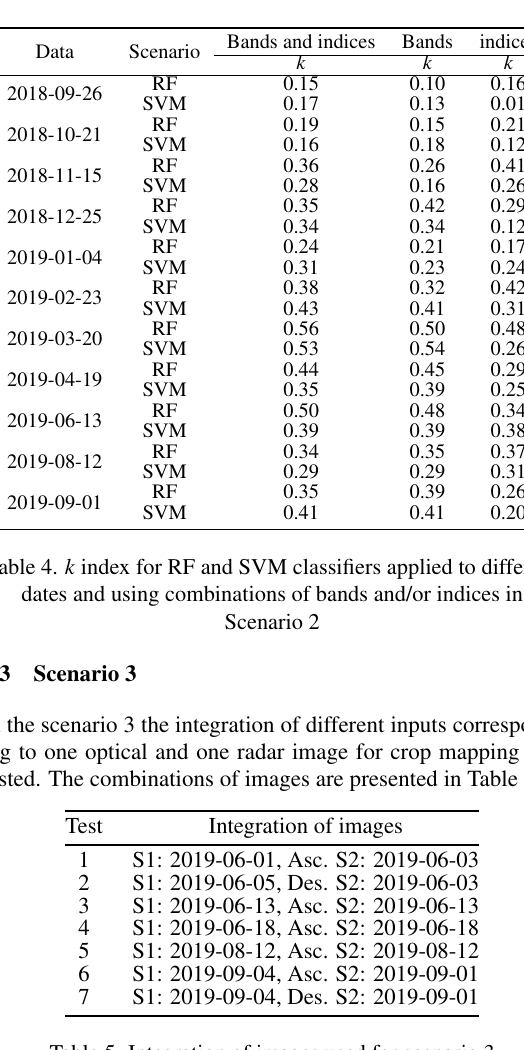
Table 5. Integration of images used for scenario 3